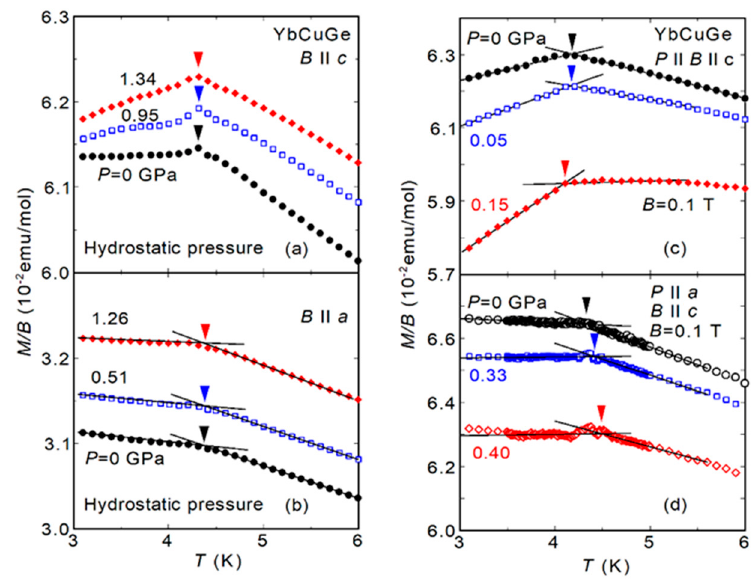
Figure 3. Temperature dependence of the magnetic susceptibility M/B of YbCuGe under hydro- static pressures ( a , b ) and uniaxial pressures ( c , d ). The data at 0.33 GPa are shifted downward by 0.1 × 10 -2 emu/mol to avoid the overlap with the data for 0 GPa. The arrows indicate the antiferro- magnetic ordering temperature T N , where T N in ( b – d ) is taken as the intersection of the two lines above and below T N .